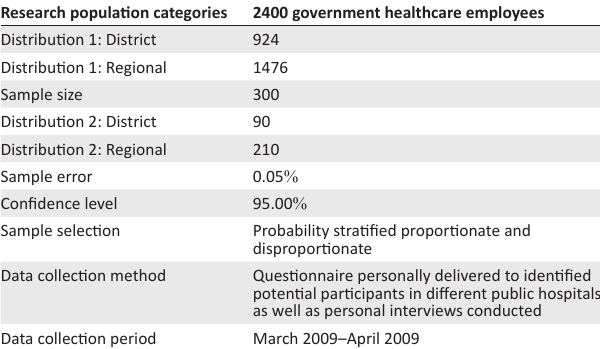
TABLE 2: Technical details of the empirical research.